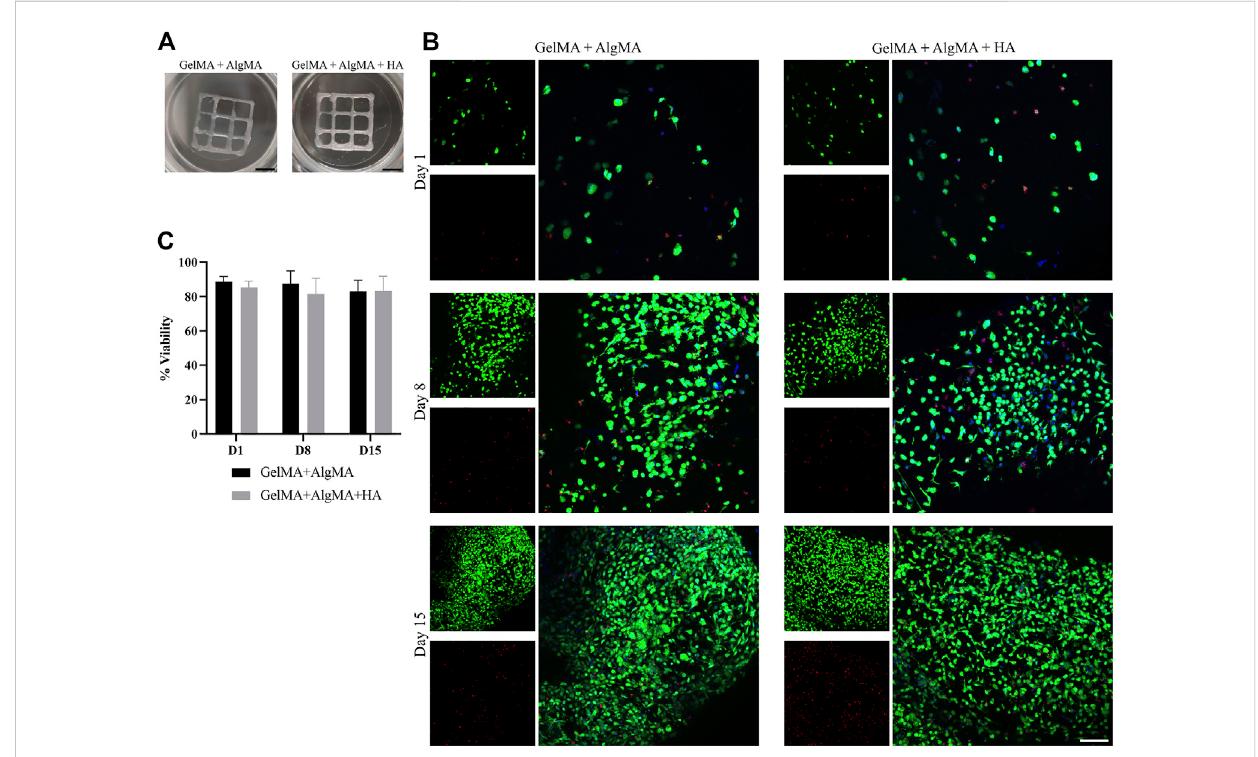
FIGURE 7 Bioprinting studies of C17.2 cells embedded in the two different bioprinted hydrogels for 15 days. (A) Photos of the bioprinted samples of both formulations(scalebar2.5 mm); (B) representativeconfocalimagesoftheviabilityassay.Nucleiarestainedinblue,calceinAMingreenrepresentsthelive cells, and EthD-1 in red represents the dead cells (scale bar 100 µm); (C) quanti fi cation of the viability of the cells. Data are presented as mean ± standard